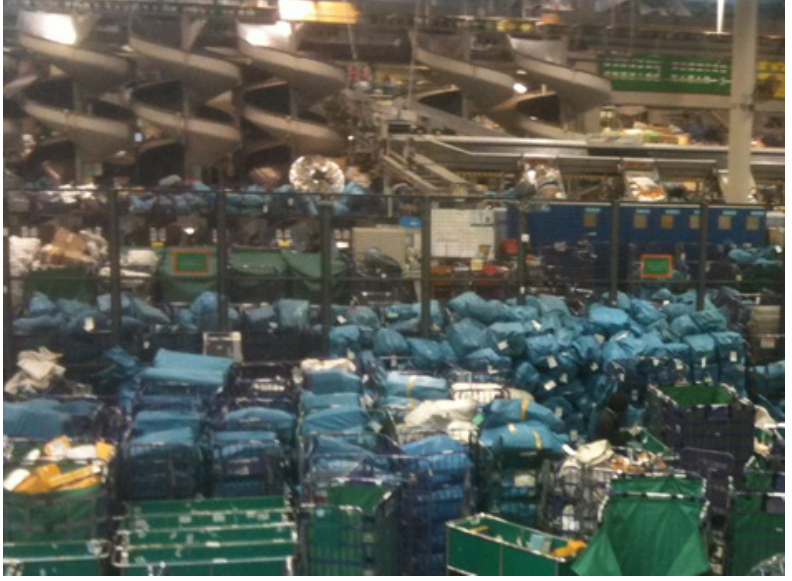
Figure 2. The environment of AMC on a typical